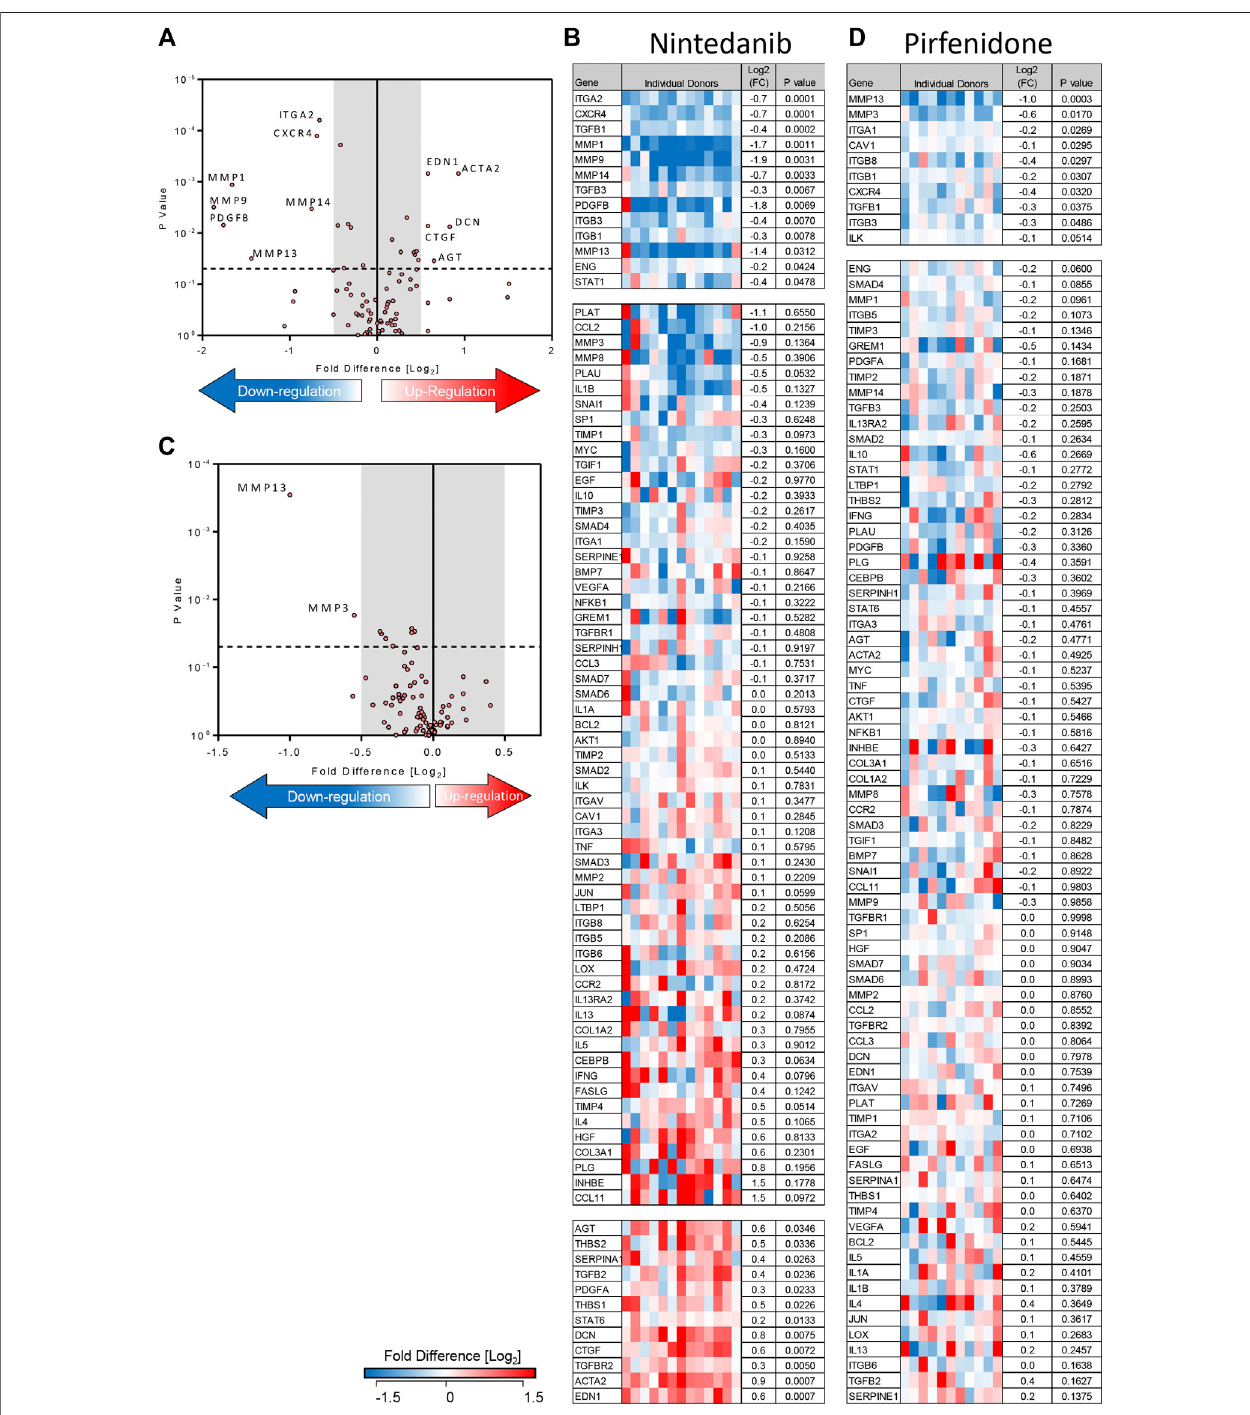
FIGURE 5 | Nintedanib and pirfenidone modulation of TGF β 1-dependent fi brotic gene expression in ex vivo human lung parenchyma. (A ) A volcano plot demonstrating that out of 84 genes studied, mRNA for seven was signi fi cantly downregulated following treatment with nintedanib (1 µM) for 7 days in comparison to TGF β 1stimulationalone,andsevengenesweresigni fi cantlyupregulated(resultsarethemeanof13individualdonors). (B )Thelog 2 FCofall84genesinindividualdonors following treatment with nintedanib for 7 days in comparison to TGF β 1 stimulation alone is depicted in this heatmap. Mean log 2 FC and statistical signi fi cance are indicated. (C) A volcano plot demonstrating that out of 84 genes studied, two were signi fi cantly downregulated following treatment with pirfenidone (500 µM) for 7 days in comparison to TGF β 1-stimulation alone (results are mean of 11 individual donors). (D) The log2 fold regulation of all 84 genes in individual donors following treatment with pirfenidone for 7 days in comparison to TGF β 1 stimulation alone is depicted in this heatmap. Mean log 2 FC and statistical signi fi cance are indicated.